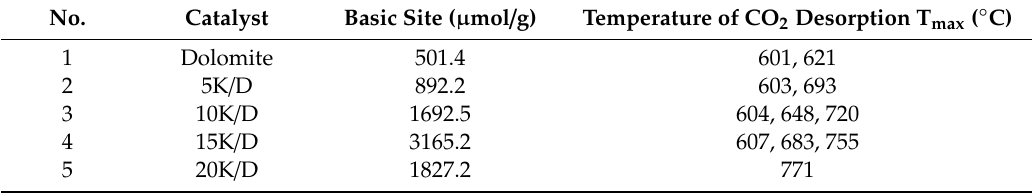
Figure 6. CO 2 -TPD profiles of ( a ) Dolomite ( b ) 5 wt% K/D ( c ) 10 wt% K/D ( d ) 15 wt% K/D ( e ) 20 wt% K/D. Table 2. Total basicity of dolomite and various composition of K/D catalyst.